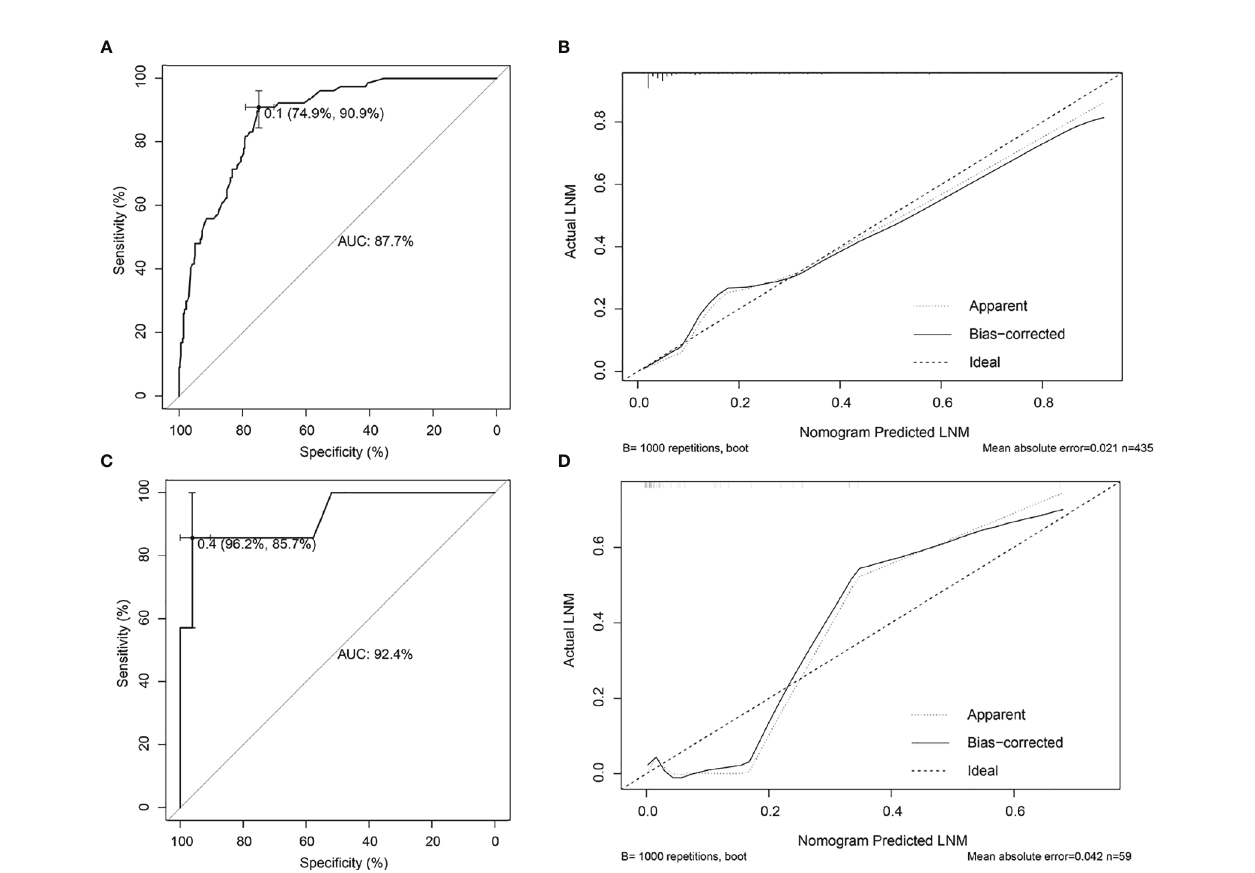
FIGURE 3 | Internal and external validations for the nomogram prediction model in female EGC patients. (A) ROC curve of the nomogram prediction model in the training set of female EGC patients; the AUC was 87.7% (95% CI: 0.8397 – 0.914). (B) Calibration curve of the nomogram prediction model for the training set of female EGC patients. (C) ROC curve of the nomogram prediction model for female EGC patients from the validation set; the AUC was 92.4% (95% CI: 0.7979 – 1). (D) Calibration curve of the nomogram prediction model in the validation set of female EGC patients. LNM, lymph node metastasis; EGC, early gastric cancer; ROC, receiver operating characteristic; AUC, area under the ROC curve.